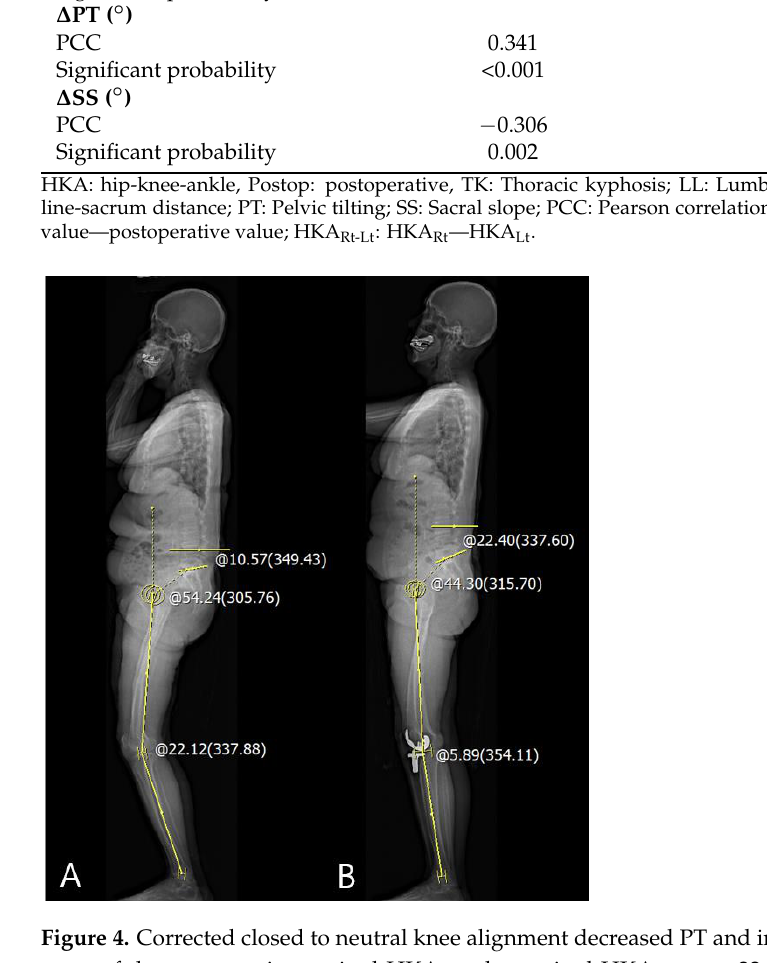
Table 5. Correlation analysis between difference in GV/FC and other parameters.